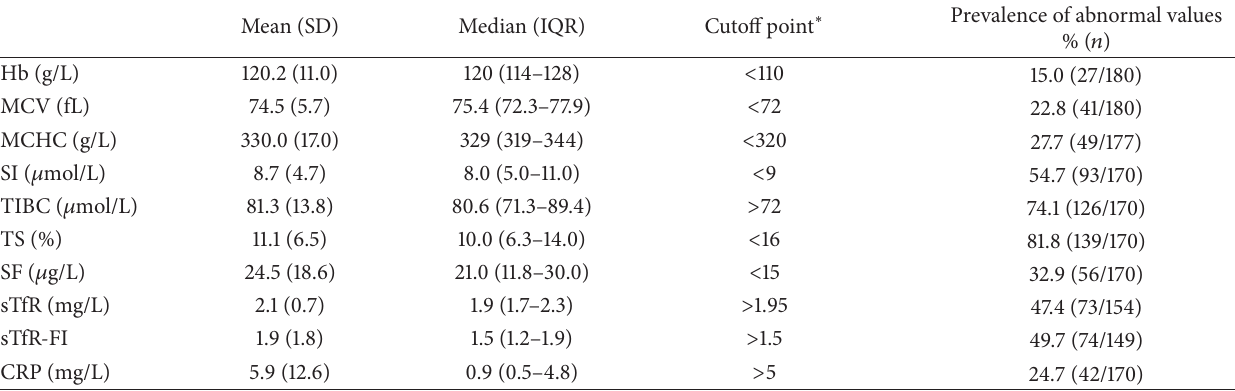
Table 3: Prevalence of abnormal values for iron status indicators regardless of inflammation and C-reactive protein (CRP) in preschool Inuit